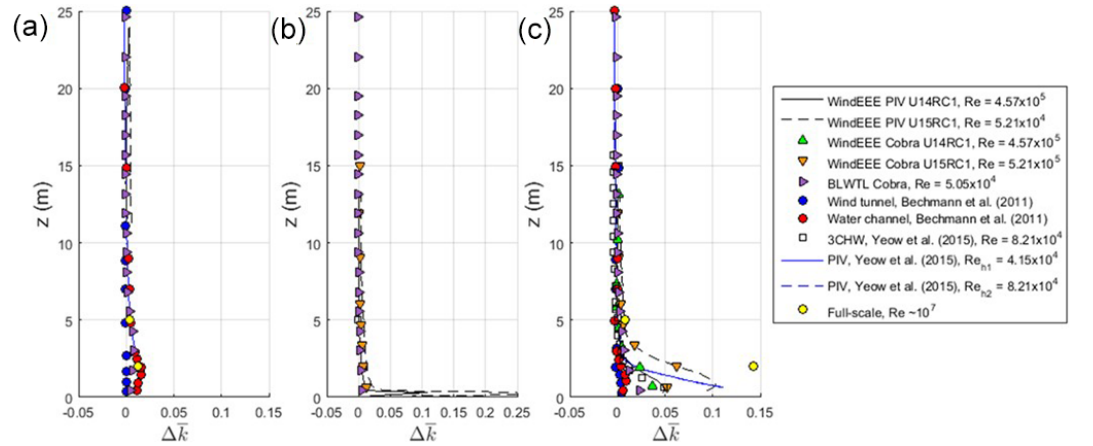
Figure 16. Vertical profiles of TKE increment (cid:49)k from PIV and Cobra probe measurements (WindEEE and BLWTL cases) at (a) M7 ( X =− 66.9m), (b) escarpment ( X =− 54.7m), and (c) M6 ( X =− 46.1m). Results from full scale and other previous physical experiments shown for